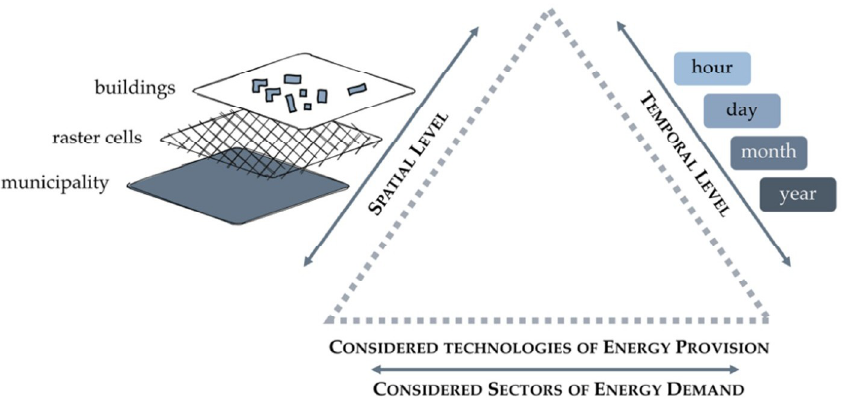
Figure 3. Overview of the spatial and temporal levels of concern, including the considered technolo- gies of energy provision and sectors of energy demand (own